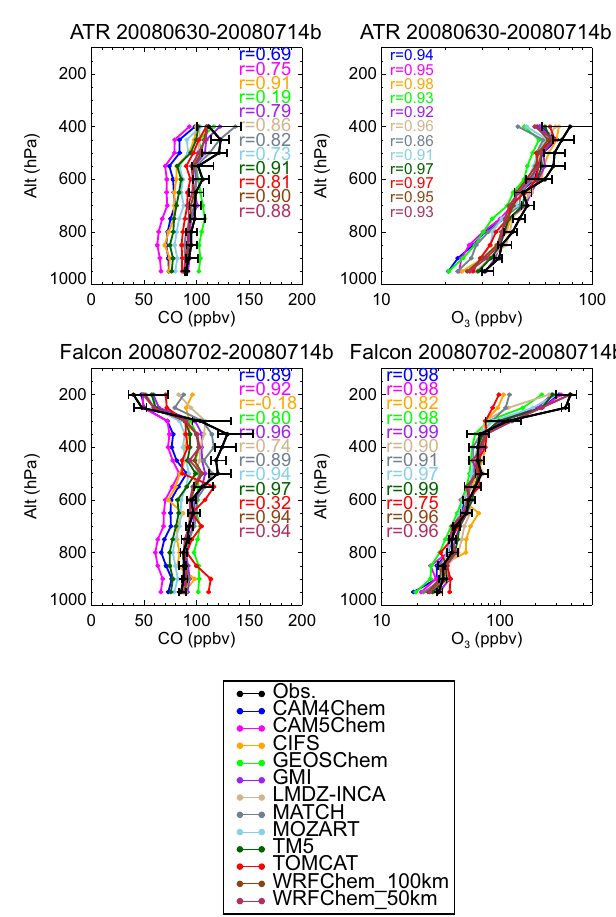
Figure 8. Vertical median profiles from the ATR-42 during the sum- mer POLARCAT-France campaign (top) and the Falcon during the summer POLARCAT-GRACE campaign (bottom) for CO (left) and O 3 (right). Pearson’s correlation coefficients are also shown. Error bars show the 25th and 75th percentiles of the